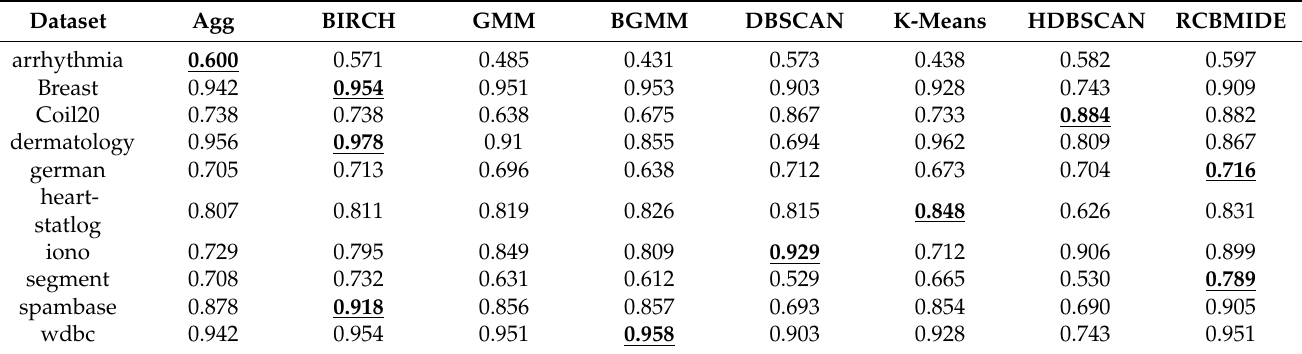
Table 3. Different clustering methods results for higher dimensions